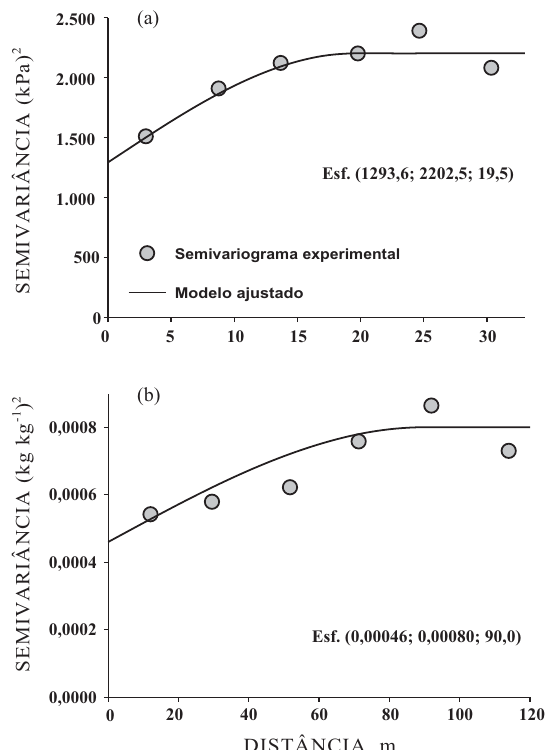
Figura 5. Semivariograma da pressão de preconso- lidação (a) e umidade do solo (b). Valores entre parênteses são efeito pepita (Co), patamar (Co + C) e alcance (a),